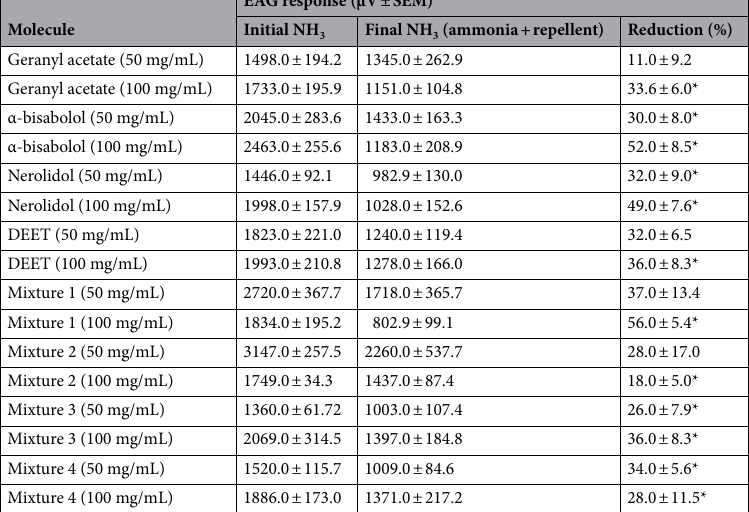
Table 3. Electroantennography signals (microvolts ± standard deviation, µV ± SEM) concerning the molecules geranyl acetate, α-bisabolol, nerolidol, DEET, and the mixtures 1, 2, 3, 4 in the 50 y 100 mg/mL concentrations applying a single mosquito per replicate and concentration. In each experiment, an initial ammonia pulse and then an ammonia-repellent pulse was applied. For each molecule and mixture in different concentrations, the percentage reduction in the post-treatment EAG ammonia signal is displayed. Mixture 1 (geranyl acetate, α-bisabolol, and nerolidol), mixture 2 (geranyl acetate and nerolidol), mixture 3 (nerolidol and α-bisabolol), and mixture 4 (geranyl acetate and α-bisabolol). (*) indicates statistically significant differences between the initial ammonia signal and the ammonia-repellent signal. One-way ANOVA, t-student